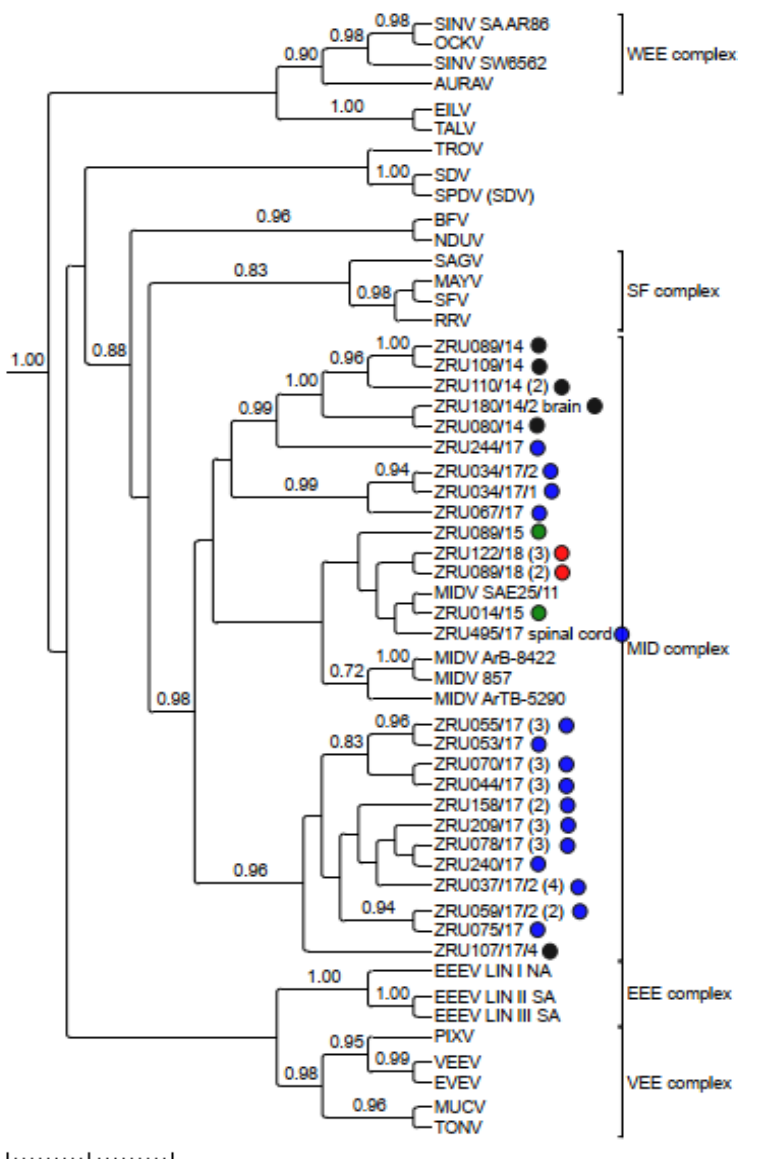
Figure 4. Rooted phylogenetic tree produced from Bayesian analysis using BEAST based on a 550- base pair E1 fragment (74 taxa, model GTR+G+I) of alphaviruses is shown. Posterior probabilities >0.7 are shown on major branches. Middelburg virus positives described in the current study are indicated with ZRU numbers and circle colours correspond to year as follows: 2014 black, 2015 green, 2017 blue and 2018 red. All sequences obtained from whole blood or serum unless otherwise indicated. Number of sequences within the same clade for samples from the same year indicated in brackets. Alphavirus complexes are indicated by brackets. The tree is drawn to scale representing the number of nucleotide substitutions per site. AURAV: Aura virus; BF: Barmah Forest virus; CHIKV: Chikungunya virus; EILV: Eilat virus; EEEV: Eastern equine encephalitis virus; EVEV: Everglades virus; MAYV: Mayaro virus; MIDV, Middelburg virus; MUCV: Mucambo virus; NDUV: Ndumu virus; OCKV: Ockelbo virus; PIXV: Pixuna virus; RRV: Ross river virus; SAGV: Sagiyama virus; SDV: Sleeping disease virus; SEV: Southern elephant seal virus; SFV, Semliki Forest virus; SINV: Sindbis virus; TALV: Taï Forest alphavirus; TONV: Tonate virus; TROV: Trocara virus; VEEV: Venezuelan equine encephalitis virus; WHAV: Whataroa virus; WEE: Western equine